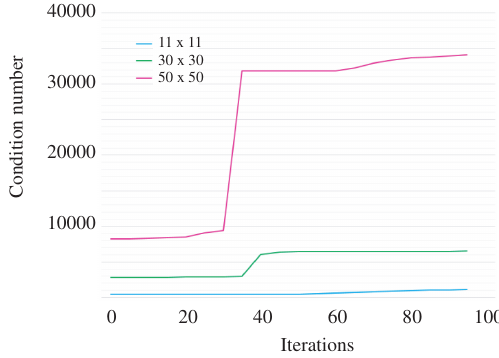
Figure 4. Time evolution of the condition number of C .